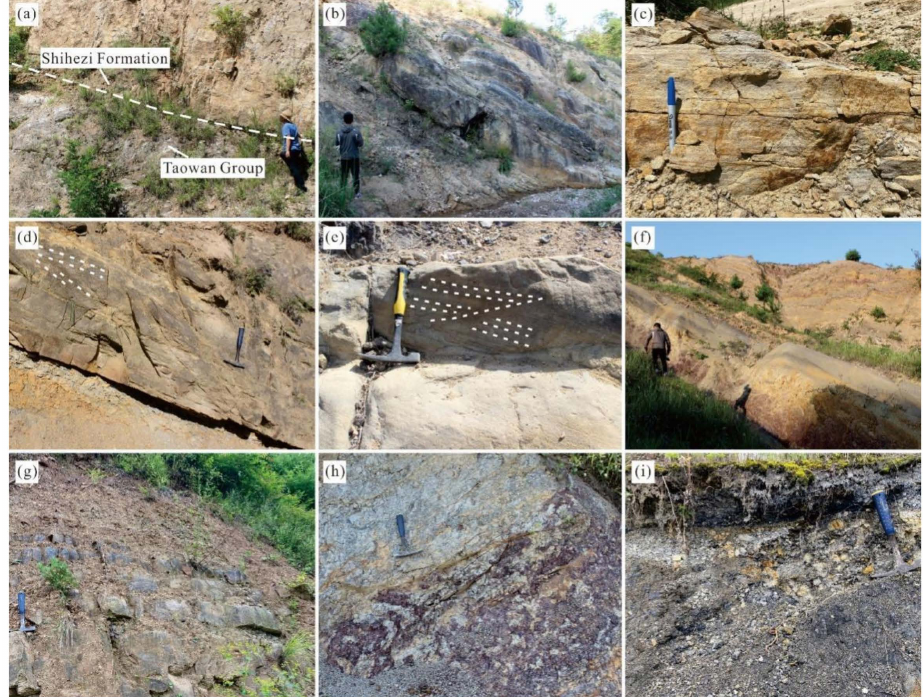
Figure 2. Field stratigraphic section and sedimentary structure of Shihezi Formation in Luonan area; ( a ) Shihezi Formation is unconformable above Taowan Group; ( b ) yellow, thick-layered sandstones; ( c ) parallel bedding sandstones; ( d ) tabular cross bedding sandstones; ( e ) wedge cross bedding sandstones; ( f ) profile of upper Permian strata; ( g ) thin mudstones intercalated with thin sandstones; ( h ) purple mottled mudstone; ( i ) coal-bearing